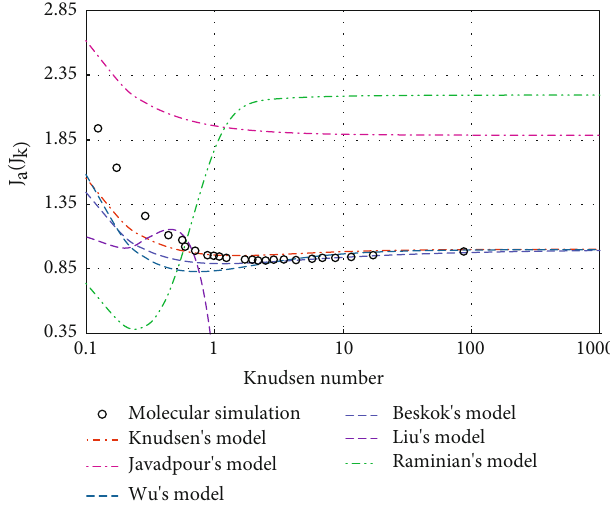
Figure 3: Comparison of existing models and molecular simulation results under high Kn .